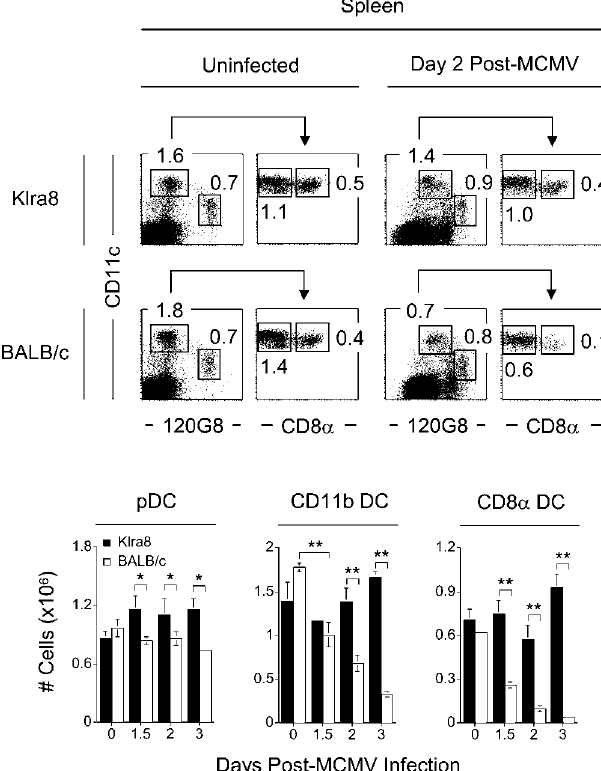
Figure 2. Antiviral NK Cell Responses Prevent Ablation of the cDC during MCMV Infection Splenic leukocytes were isolated from Klra8 and BALB/c mice and analyzed for the frequency of pDCs (120G8 þ CD11c int ), CD11b cDCs (120G8 (cid:2) CD11c hi CD8 a (cid:2) ), and CD8 a cDCs (120G8 (cid:2) CD11c hi CD8 a þ ) within the DX5 (cid:2) and TCR b (cid:2) population. Numbers in dot plots represent percent pDCs, percent CD11b cDCs, and percent CD8 a cDCs within the total splenocyte population for one representative animal from groups of three mice for days 0 and 2 post–MCMV infection. Graphs represent the total numbers (in millions) of pDCs, CD11b cDCs, and CD8 a cDCs present in the spleens of Klra8 and BALB/c mice on days 0, 1.5, 2, and 3 post– MCMV infection. Results are expressed as mean 6 SD of three mice per group. One experiment representative of three is shown. * p (cid:3) 0.05; ** p (cid:3)